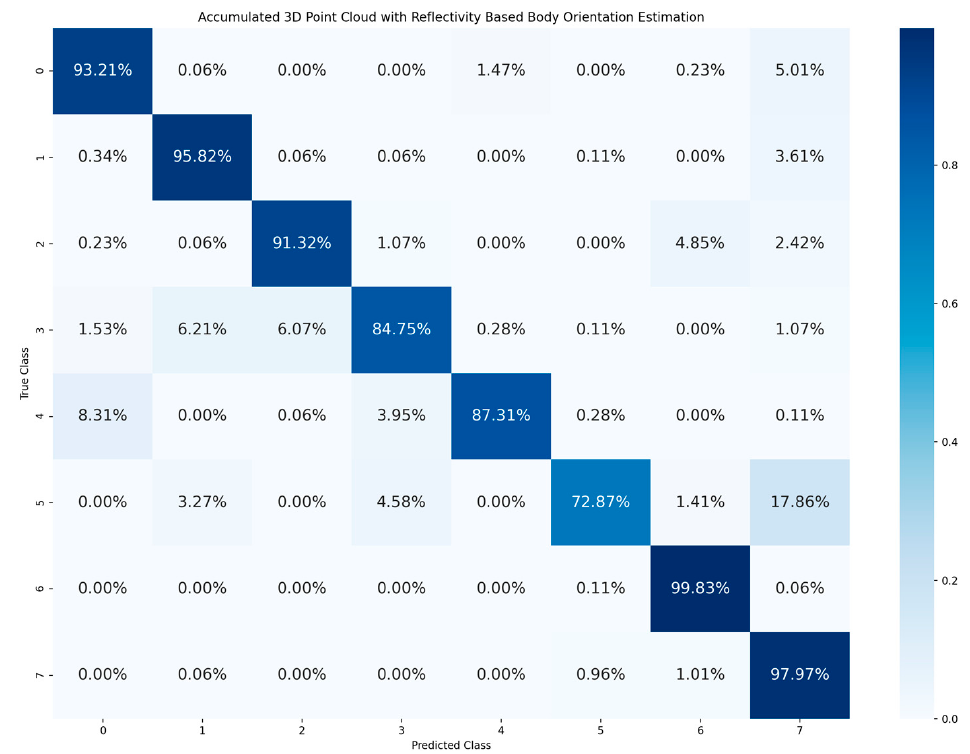
Figure 9. Confusion matrix of body orientation estimation accumulated from joined body and head orientation estimation using 3D point cloud data with reflectivity.